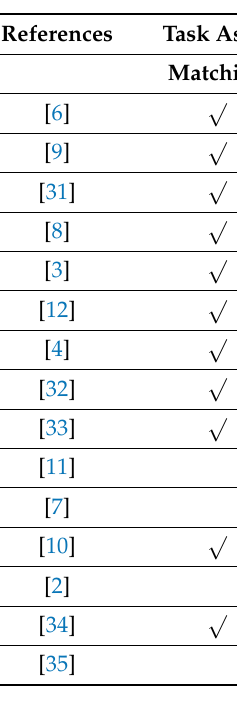
Table 1. Summary of the literature for task assignment in